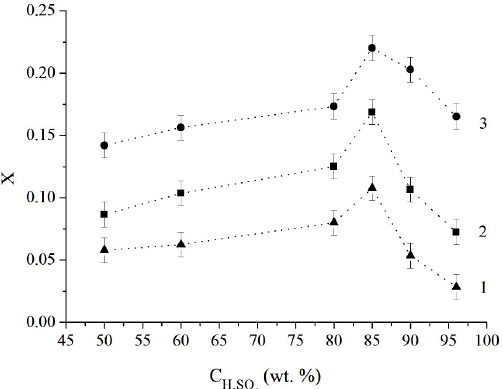
Figure 6. The dependence of the leaching degree of titanium on the concentration of sulfuric acid and the duration of the leaching process 120 min (1), 240 min (2), and 420 min (3). It is necessary to determine the limiting stage of the process to identify possible ways to optimize it. Various equations were used to describe the heterogeneous reactions to analyze the kinetic data presented above. Statistical processing of the data on the Fisher dispersion relation at a significance level of 0.05 showed that the linearity hypothesis could be accepted for the most known equations, but the values of their correlation coefficients differed significantly. The best results in describing the rate of sulfuric acid decomposition of ilmenite were obtained with the equations of the “contracting sphere” model.